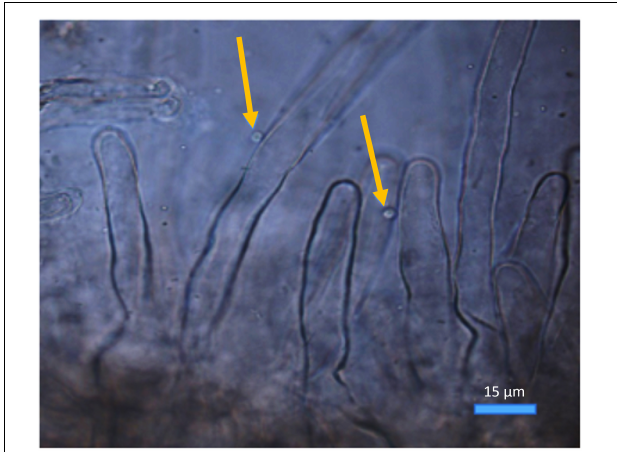
FIGURE 2 | Spongospora subterranea zoospores (arrowed) attached to potato (cv. Iwa) root hairs following 24-h incubation (scale bar = 15 µ m; magnification 400x).